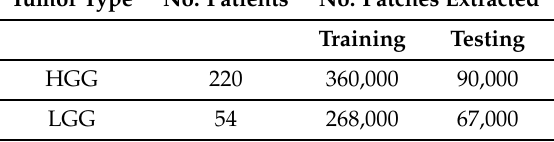
Table 2. Data set used for proposed technique: Four MRI modalities are used for both tumor types High-Grade Glioma (HGG) and Low-Grade Glioma (LGG). The modalities are T1-weighted (T1), 2-weighted (T2), T1-weighted (T1c), and FLAIR. The initial two parameters represent the tumor type and number of patients, and the next parameter represents the number of patches extracted for training and